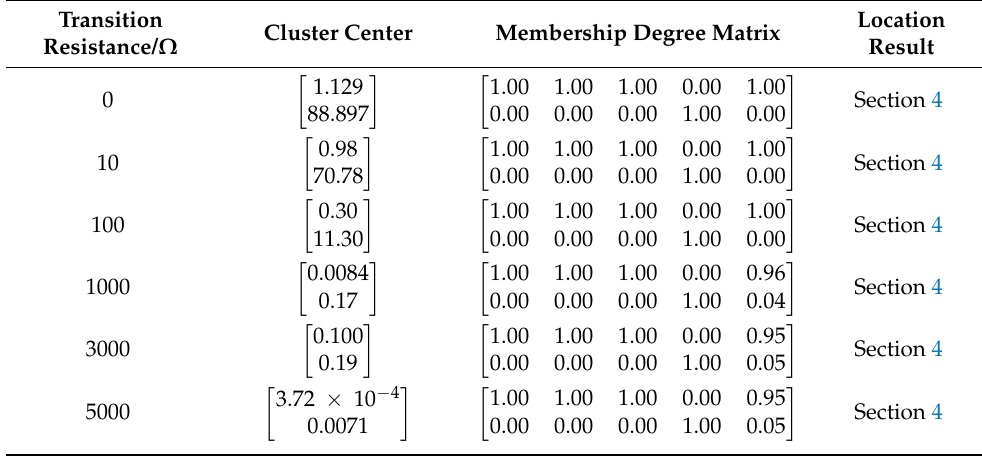
Table 2. Location results under different transition resistances.